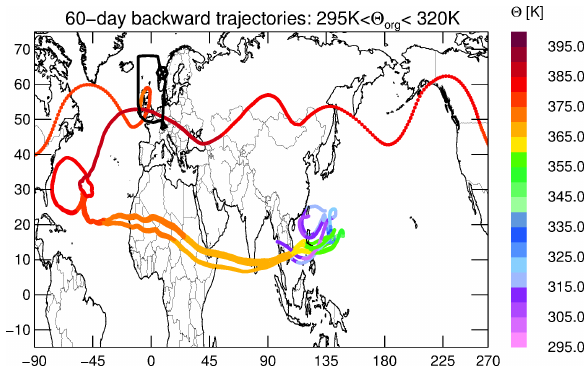
Figure 8. Forward trajectories starting at the position of the typhoon Figure 9. Different 60-day backward trajectories for the tropo- Fig. 8. Forward trajectories starting at the position of the typhoon Bolaven (15 ◦ N- 25 ◦ N, 128 ◦ E-140 ◦ E and below 310K potential Fig. 9. Different 60-day backward trajectories for the tropospheric signal between 08:05UTC and 08:23UTC (see Fig. 2; enhanced values ≈ Bolaven (15–25 ◦ N, 128–140 ◦ E and below ≈ 310K potential tem- temperature) marked as a grey box on 23 August 2012 12:00 UTC. Shown are only trajectories that reach the region of interest during the spheric signal between 08:05UTC and 08:23UTC of the TACTS of CH 4 , CO , and H 2 O and reduced O 3 occurring before the region of interest) originating at a low level of potential temperature ( Θ org = flight on 26 September 2012 12:00 UTC (at locations between 365K and 385K, between 55 ◦ N and 70 ◦ N, and between 20 ◦ W and 0 ◦ W). 295–320K). The very rapid uplift over Southeast Asia is caused by typhoon Haikui. perature) marked as a grey box on 23 August 2012 12:00UTC. flight on 26 September 2012 (see Fig. 2; enhanced values of CH 4 , The flight path shown in black is transformed to synoptic 12:00 UTC locations. Shown are only trajectories that reach the region of interest dur- CO and H 2 O and reduced O 3 occurring before the region of inter- ing the flight on 26 September 2012 12:00UTC (at locations be- est) originating at a low level of potential temperature ( (cid:50) org = 295– tween 365 and 385K, between 55 and 70 ◦ N, and between 20 and 320K). The very rapid uplift over Southeast Asia is caused by ty- 0 ◦ W). The flight path shown in black is transformed to synoptic phoon Haikui. The flight path for the TACTS flight on 26 September 12:00UTC locations. 2012 (at flight time) is shown in